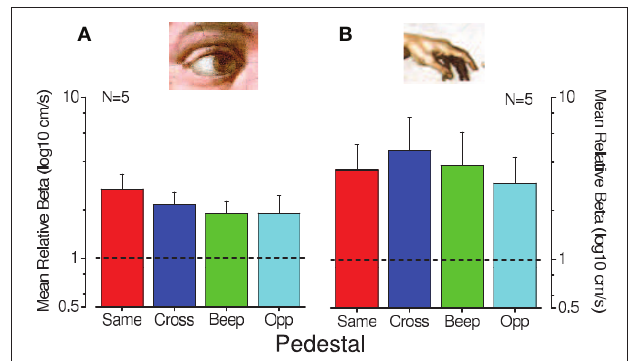
Figure 7 | Steepness of psychometric functions for the conditions that produce cross-modal facilitation. Mean normalized psychometric function steepness of five observers for visual (A) and tactile (B) conditions. Individual steepness (SD of psychometric functions) were divided by the steepness for the no-pedestal condition, then averaged across subjects (with error bars representing ± 1 SEM). The dashed line at unity indicates no-pedestal effect: red bars indicate thresholds for pedestals of the same modality, blue pedestals of different modality, green for the auditory tone and cyan for opposite direction of motion.